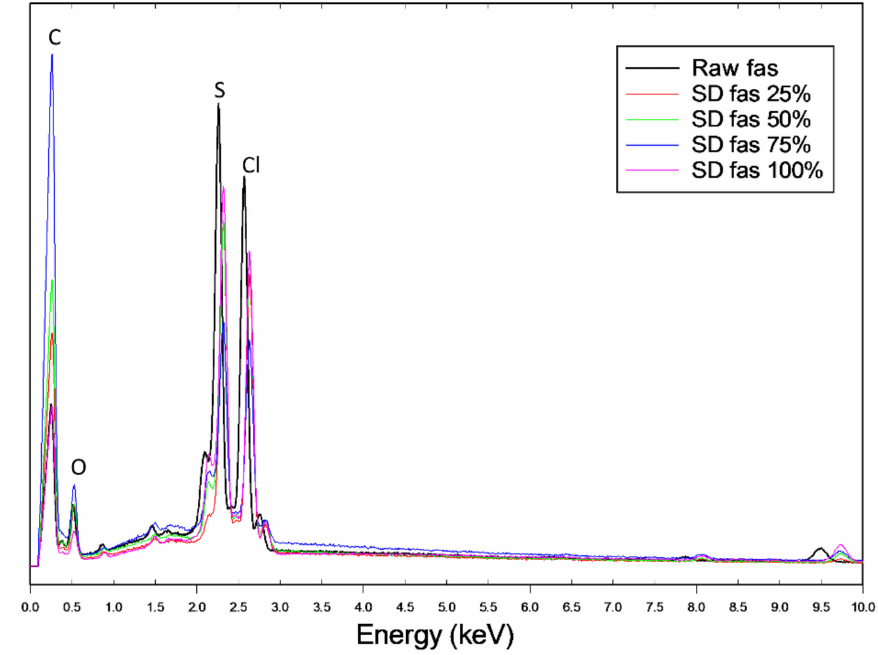
Figure 3. EDX atomic composition spectra of raw FAS and SD FAS showing characteristic peaks for carbon (C), oxygen (O), sulfur (S), and chlorine (Cl) atoms.